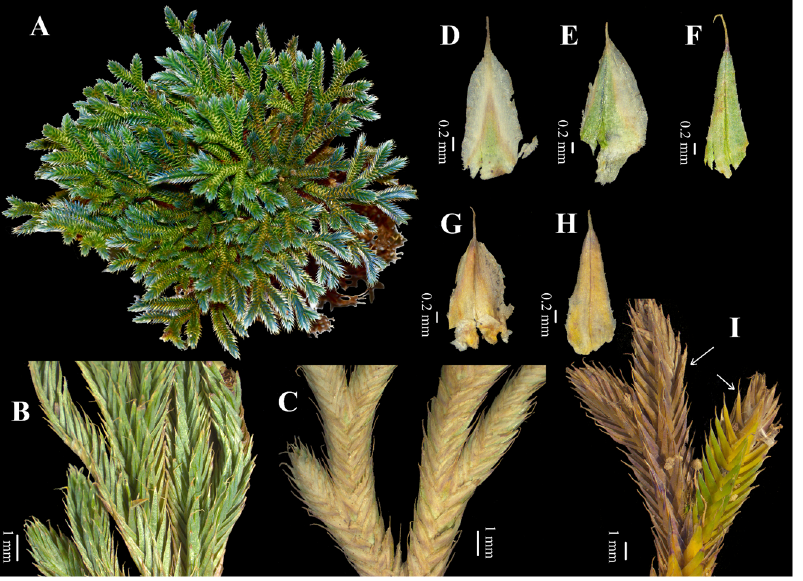
Figure 3. Morphology of Selaginella iridescens X. C. Zhang and Y. R. Wang sp. nov. ( A ) Individual; ( B ) adaxial view of branchlets; ( C ) abaxial view of branchlets; ( D ) axillary leaf; ( E ) ventral leaf; ( F ) dorsal leaf; ( G ) ventral sporophyll; ( H ) dorsal sporophyll; ( I ) adaxial view of strobili (arrows).